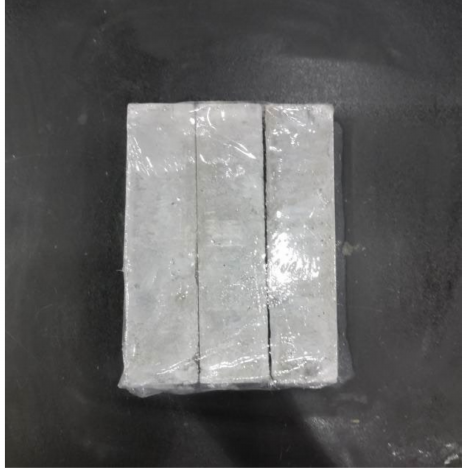
Figure 9. The demoulded specimens coverd with film